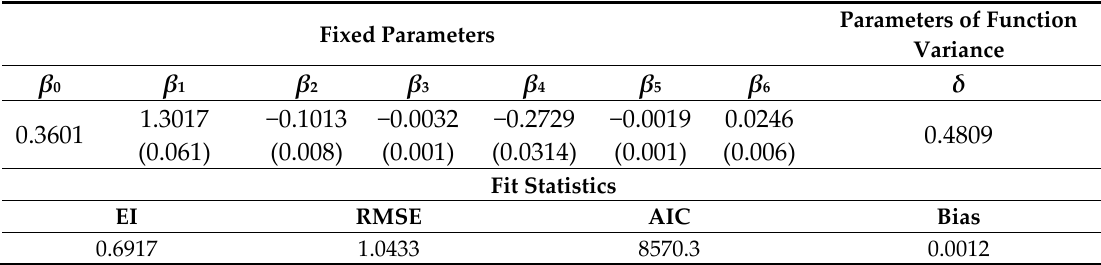
Table 6. Estimated parameters and fitting statistics of GM2.